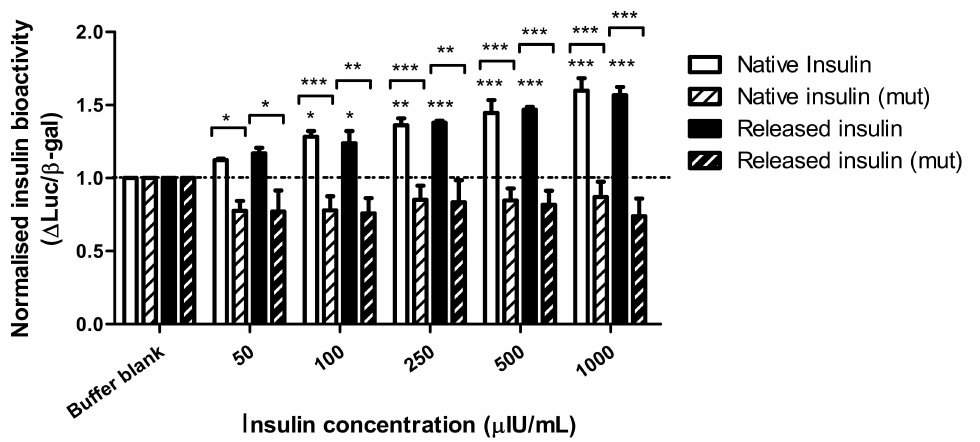
Figure 5. The ratio of luciferase and β -galactosidase expression in endogenous insulin receptor- expressing HepG2 cells transfected with wt (SynSRE-T-Luc) or mutant (mut, SynSRE-T-mut-Luc), following exposure to native and bead-released insulin. Data are presented as mean ± SEM, n = 3 individual bead batches. * p < 0.05, ** p < 0.01, *** p < 0.001 compared to buffer blank. Bracketed values compared responses from enriched and mutant